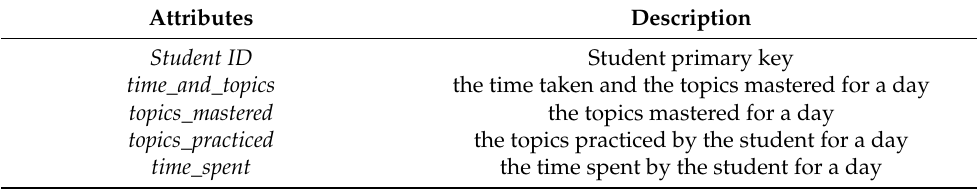
Table 2. Attributes in